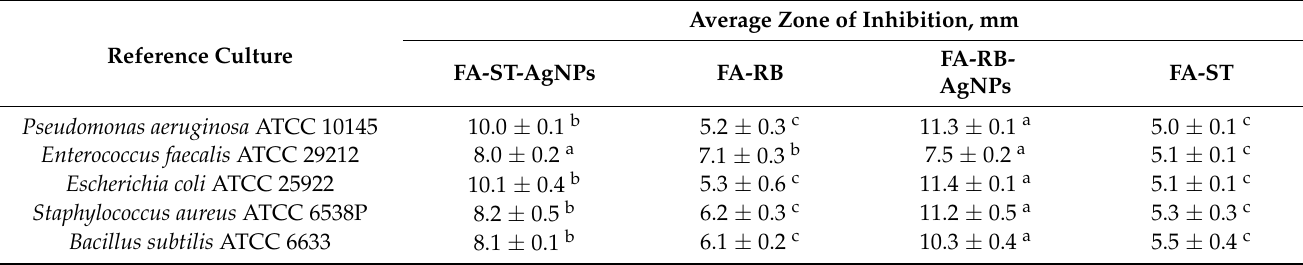
Figure 6. Scanning electron microscopy (SEM) images of uncapped ( A ) and capped ( B ) with poly- vinylpyrrolidone synthesized silver nanoparticles produced by synthetic trans -ferulic acid, capped silver nanoparticles produced by rye bran-derived trans -ferulic acid and trans - iso -ferulic acids ( C ). EDS patterns ( D , D1 , D2 ) of silver nanoparticles produced by rye bran-derived trans -ferulic acid and trans - iso -ferulic acids captured at two randomly selected regions for EDS analysis.